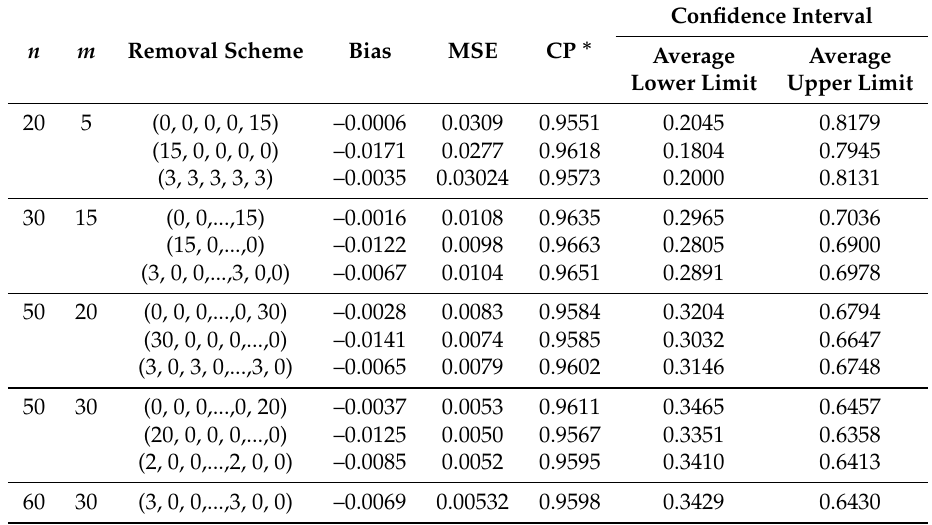
Estimation results of δ s , k using the parametric percentile bootstrap method for